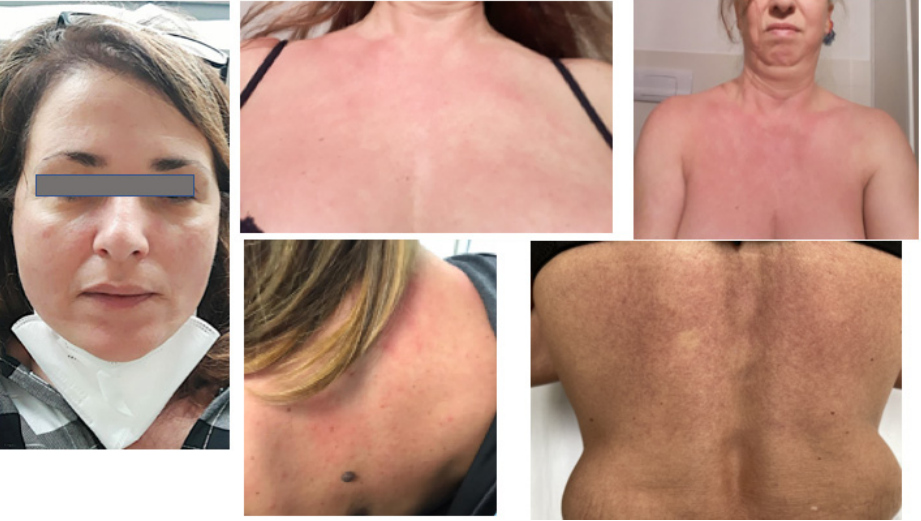
Figure 1. Erythematous edematous and maculopapular eruptions in 4 different patients after Pfizer/BioNTech vaccination.